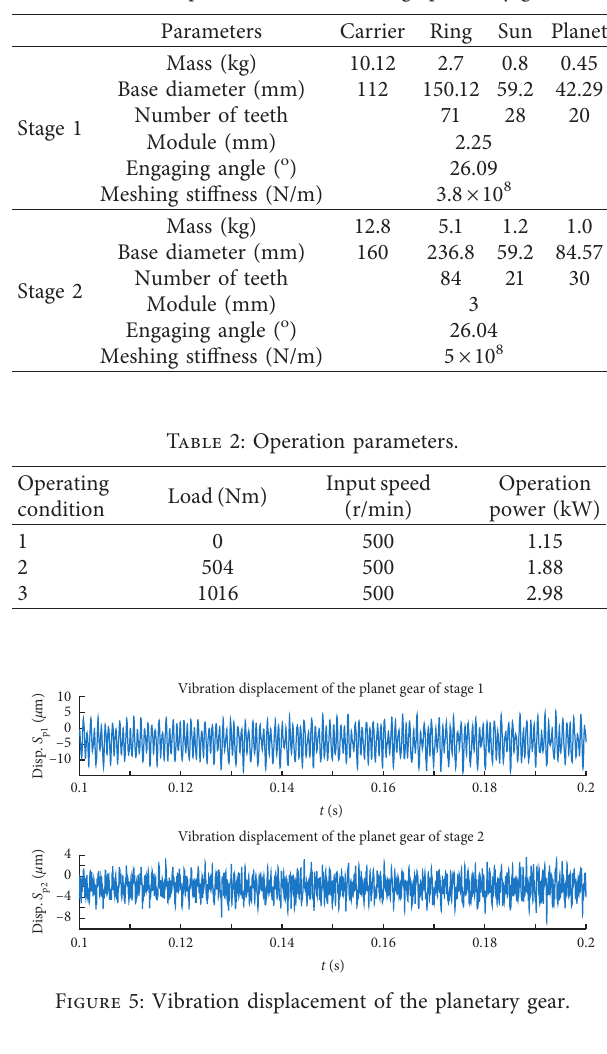
Table 1: The parameters of the 2-stage planetary gear.